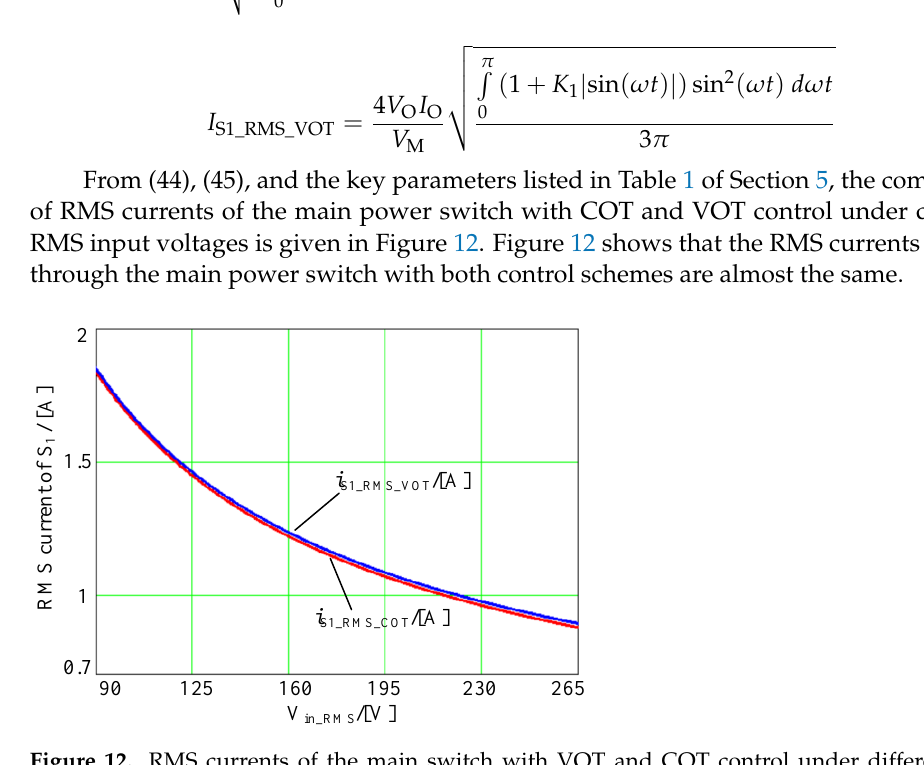
Figure 12. RMS currents of the main switch with VOT and COT control under different RMS input voltage .